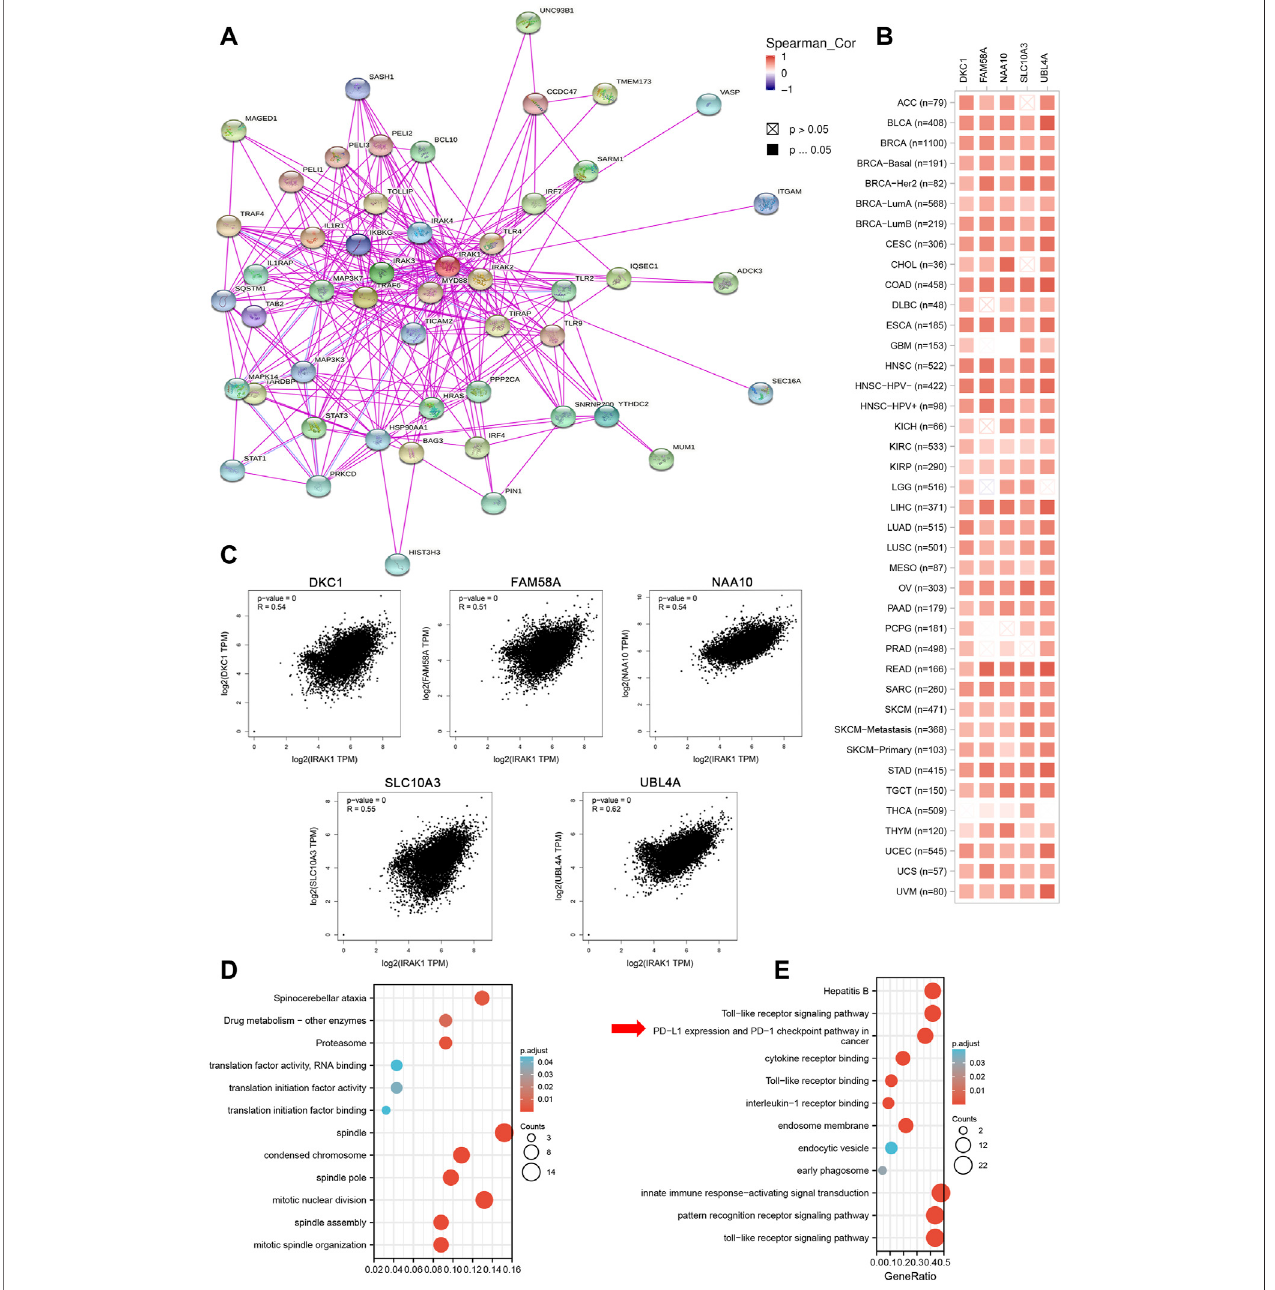
FIGURE5| IRAK1-relatedgeneenrichmentanalysis. (A) IRAK1bindingproteinsweredeterminedbyusingSTRINGtool. (B) Top100IRAK1correlatedgeneswere analyzed by using GEPIA2 tool and the correlation of IRAK1 and top fi ve genes (DKC1, FAM58A, NAA10, SLC10A3, UBL4A) were shown. (C) The correlation map of IRAK1andtop fi vecorrelatedgenesinTCGApan-cancerpanelwasanalyzedbyusingTIMER2.0. (D) GO-KEGGpathwaysanalysiswasperformedbasedontheIRAK1 correlated genes. (E) GO-KEGG pathways analysis was performed based on the IRAK1 binding genes.